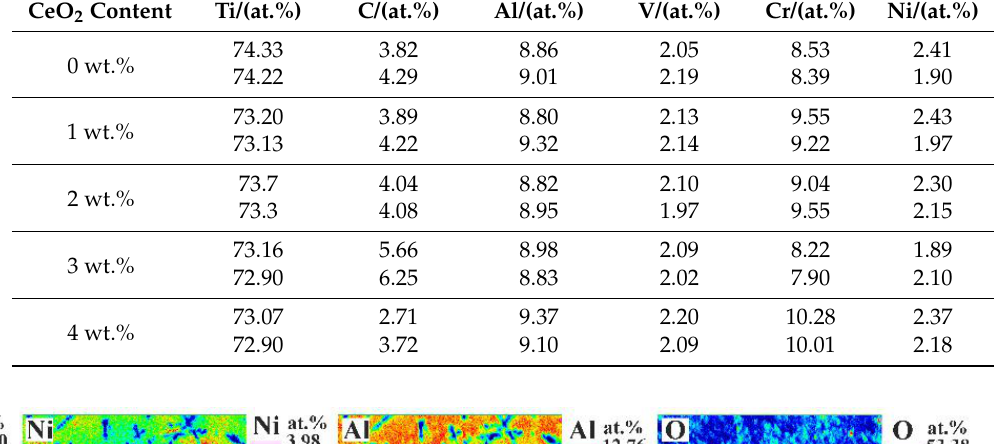
Table 1. The EDS results of matrix in the coatings with different CeO 2 contents.